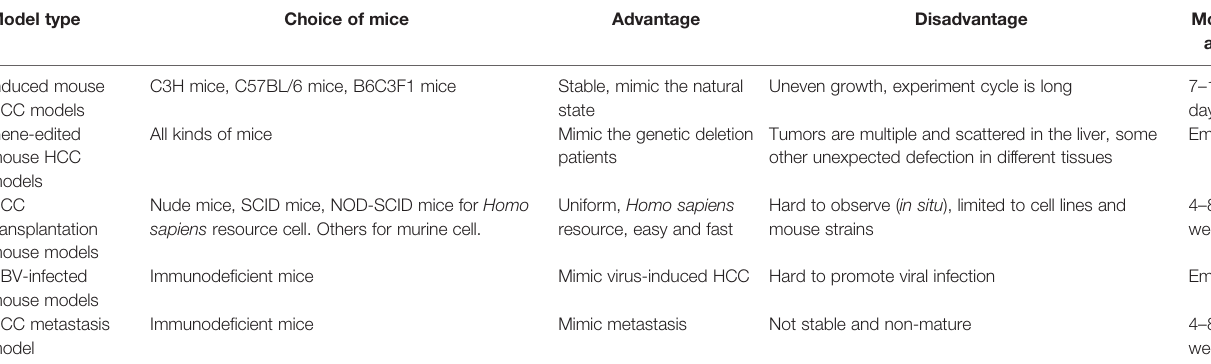
TABLE 1 | Comparison of different types of mouse HCC